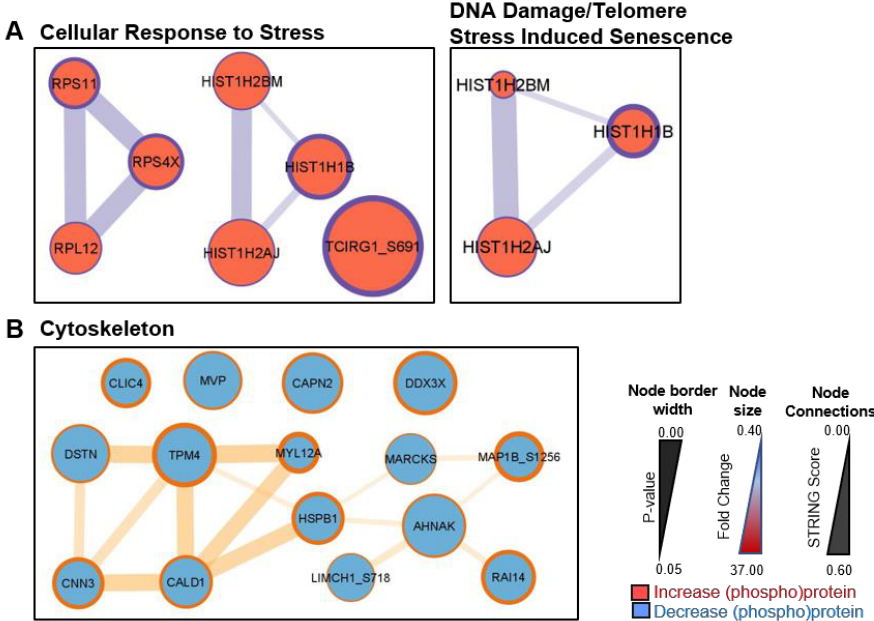
Figure 6. STRING/Cytoscape network analysis of differentially regulated CAF proteins and phosphosites. Enriched signalling networks of ( A ) increased and ( B ) decreased CAF (phospho)proteins in BPH-1 co-culture. Node size is representative of protein expression fold change (co-culture/monoculture); node border width is representative of the p -value for co-culture/monoculture comparison for each protein; node connection line thickness is representative of STRING score between connected proteins.